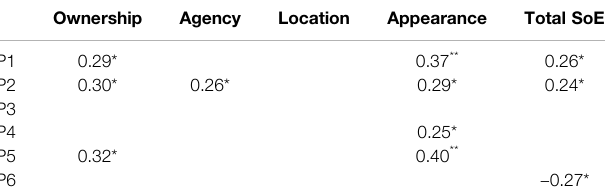
TABLE 6 | Spearman correlations betweenthe embodimentscores and thepost- experiment questionnaire (*: p < 0.05, ** : p < 0.01, *** : p < 0.001).